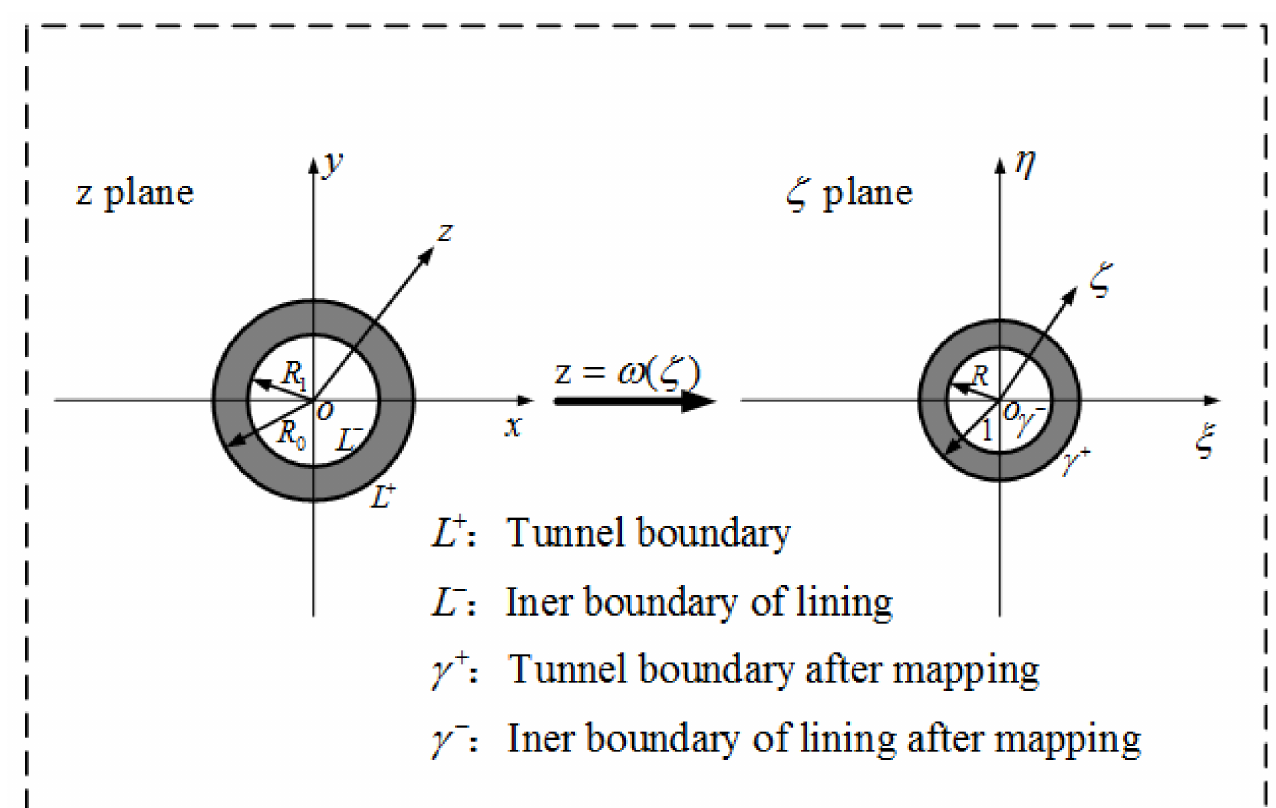
Figure 2. Lined circular tunnel and mapped